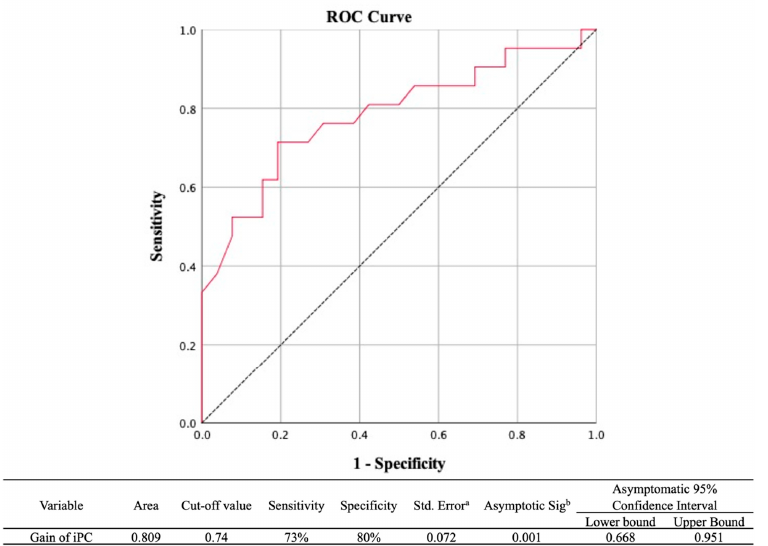
Figure 2. ROC curves for the IVN groups in the iPC gain to predict differentiation of IVN from SVN. The optimal cutoff value for gain in the iPC provides the sensitivity (73%) and specificity (80%). The black dashed line indicates a hypothetically useless diagnostic test. ROC, receiver operating characteristic; SVN, superior vestibular nerve; IVN, inferior vestibular nerve; PC, posterior canal; i = ipsilesional. a. Under the nonparametric assumption. b. Null hypothesis: true area = 0.5.